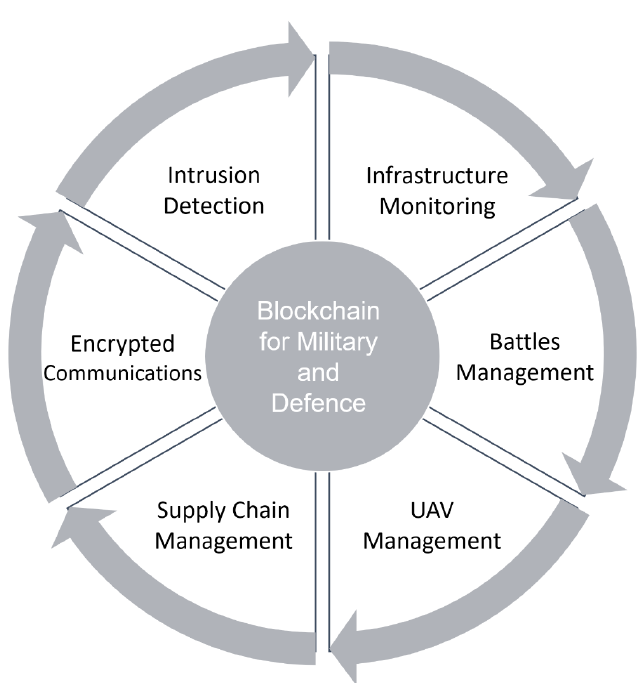
Figure 10. Blockchain for military and